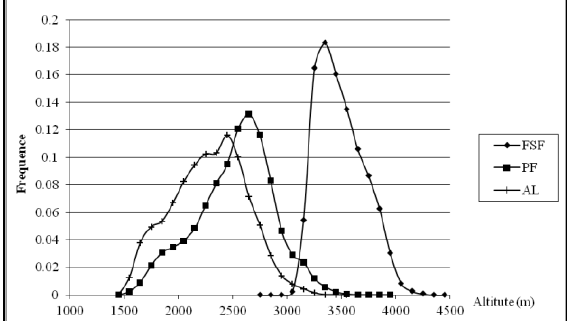
Figure 9. Frequency distribution of fir and spruce forest (FSF), pine forest (PF), and agricultural land (AL) obtained by ANN classification using DEM as an extra